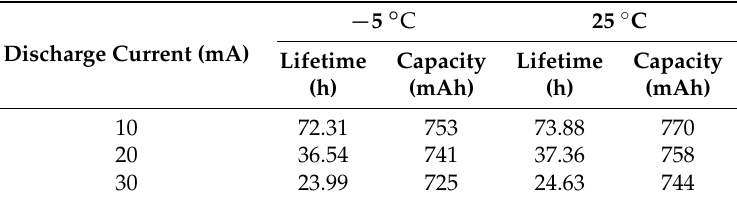
Table 1. Experimental results.